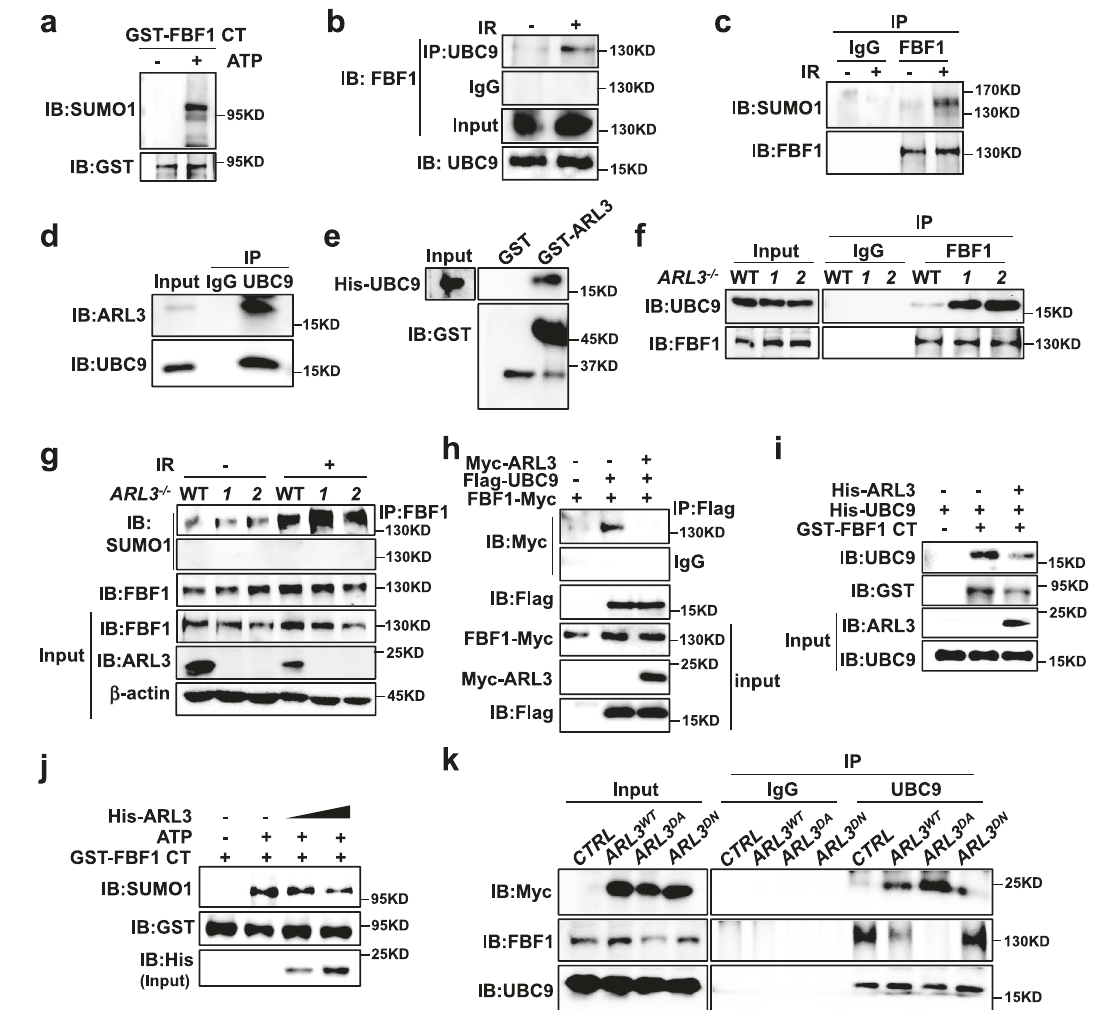
Fig. 4 | DNA damage induces FBF1-UBC9 association and FBF1 SUMOylation, which are negatively regulated by the ARL13B-ARL3 GTPase cascade. a In vitro SUMOylation assay of FBF1 and western blot using a SUMO1 antibody. GST tagged 598 – 1148 domain FBF1 was puri fi ed using E. coli . b Endogenous UBC9 immuno- precipitates with FBF1 in RCTE cells at day 7 after irradiation. c Endogenous FBF1 immunoprecipitates with SUMO1 in RCTE cells at day 7 after irradiation. d EndogenousUBC9immunoprecipitateswithARL3inRCTEcells. e GSTpull-down assay shows the ARL3 and UBC9 interaction. f Endogenous FBF1 immunoprecipi- tateswithUBC9inWTor ARL3 -/- RCTEcellsatday7afterirradiation. g Endogenous FBF1immunoprecipitateswithSUMO1inWTor ARL3 -/- RCTEcellswithorwithoutIR